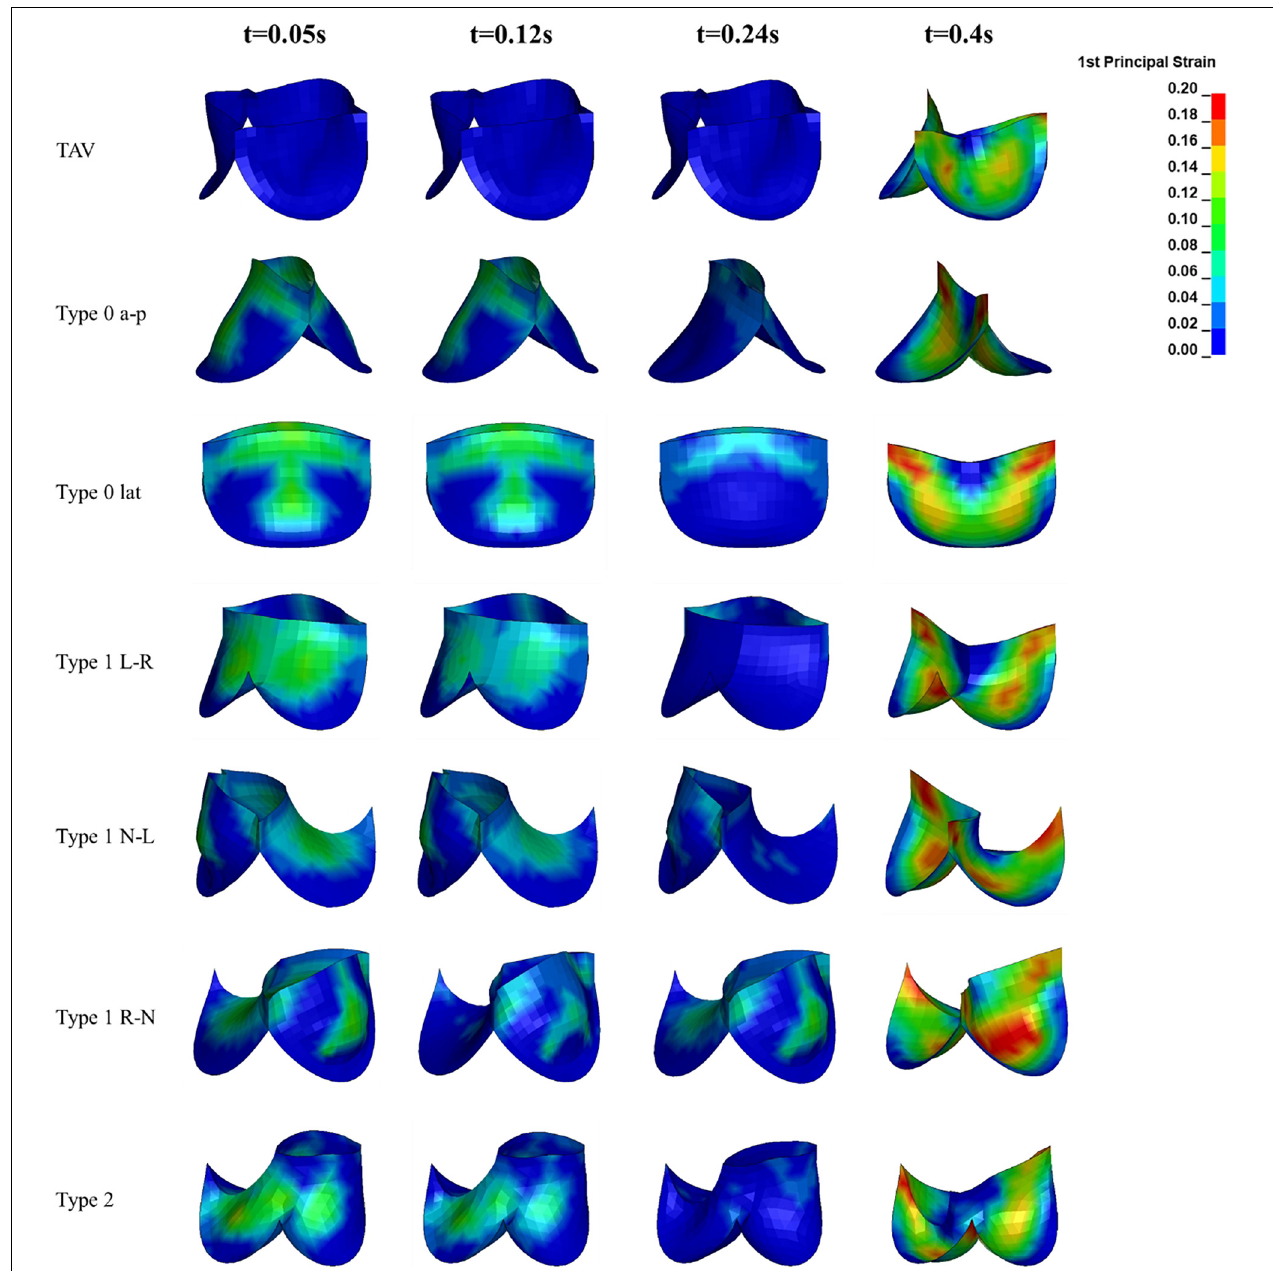
FIGURE 8 | The leaflet strain distribution of TAV and BAV during cardiac cycle ( t = 0.05, 0.12, 0.24, 0.4